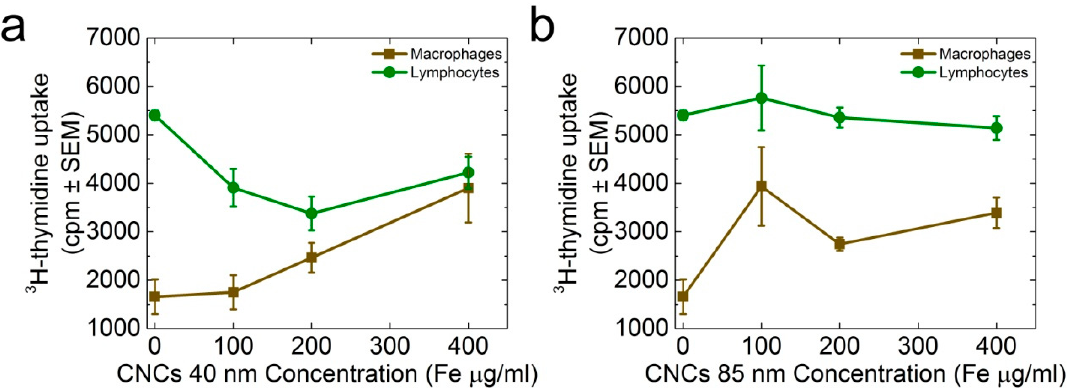
Figure 7. The proliferation of macrophages and lymphocytes incubated with CNCs [40 nm ( a ) and 85nm ( b )] was evaluated against the uptake of 3 H-thymidine ( 3 HTdR).